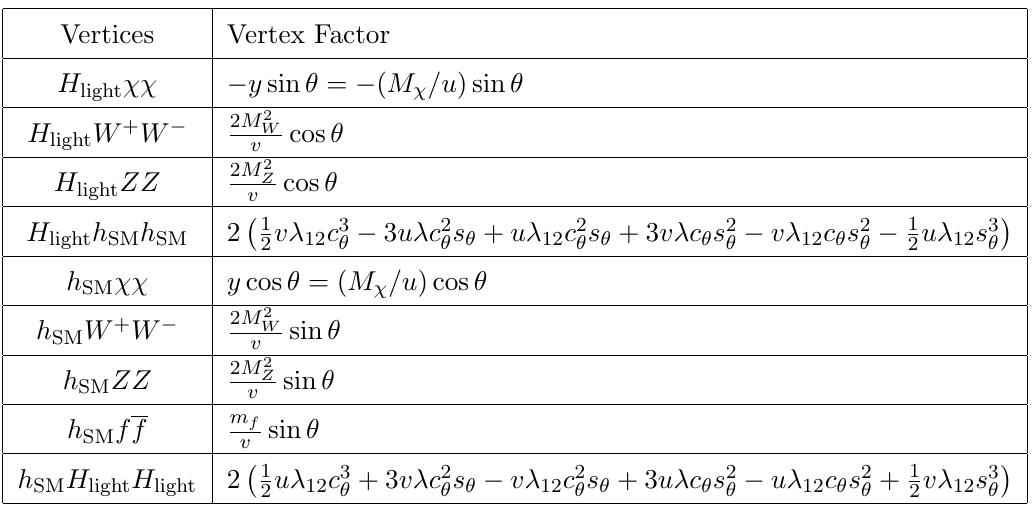
Table 4 . Vertices that connect DM to the SM in low mass region. Vertex factors are written assuming (cid:21) 1 = (cid:21) 2 = (cid:21)